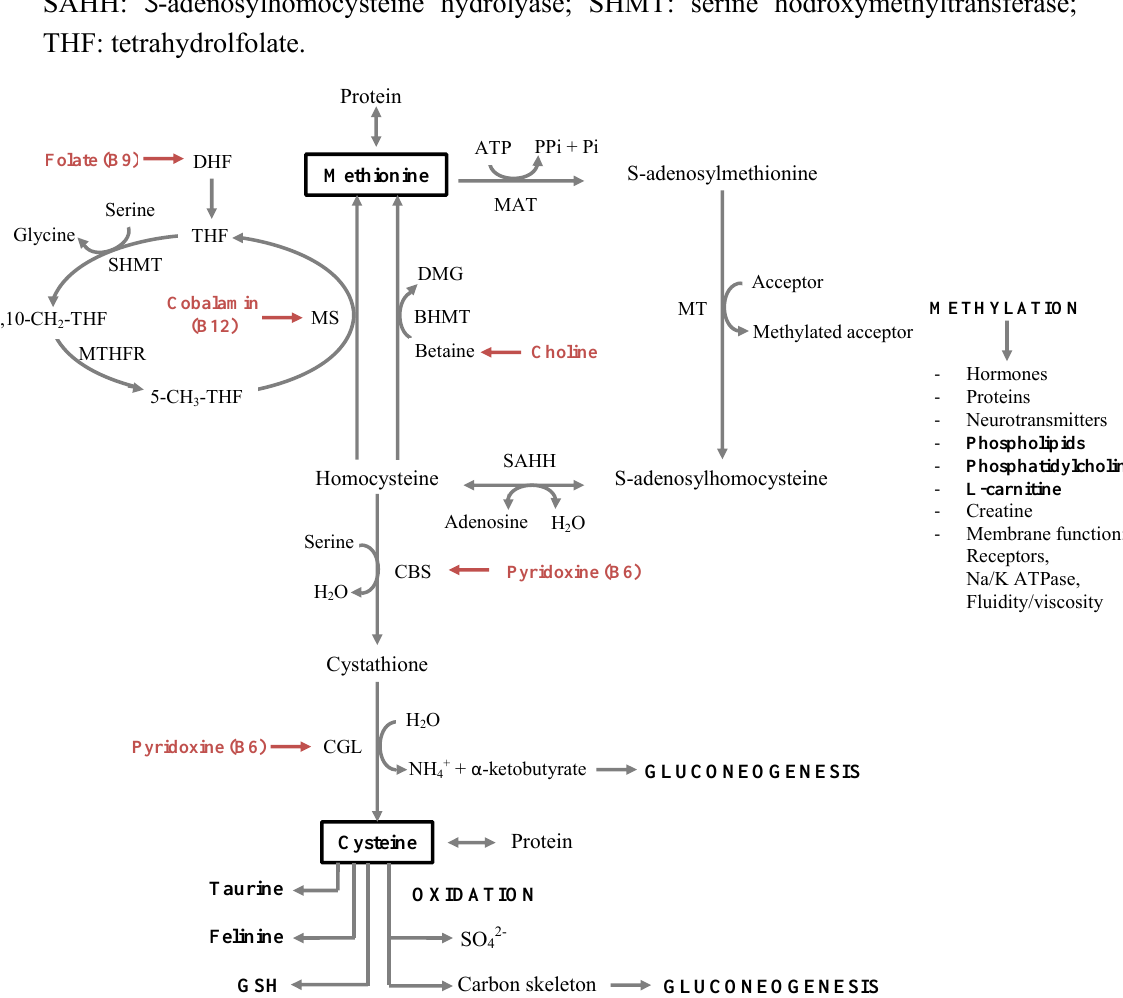
Figure 1. Major pathways of sulphur-containing amino acid metabolism in the feline, involving the esstential amino acids, methionine, cysteine and taurine, and the B-vitamines, -THF: 5-methyl-tetrahydrofolate; cobalamin, choline, folate and pyridoxine. 5-CH 3